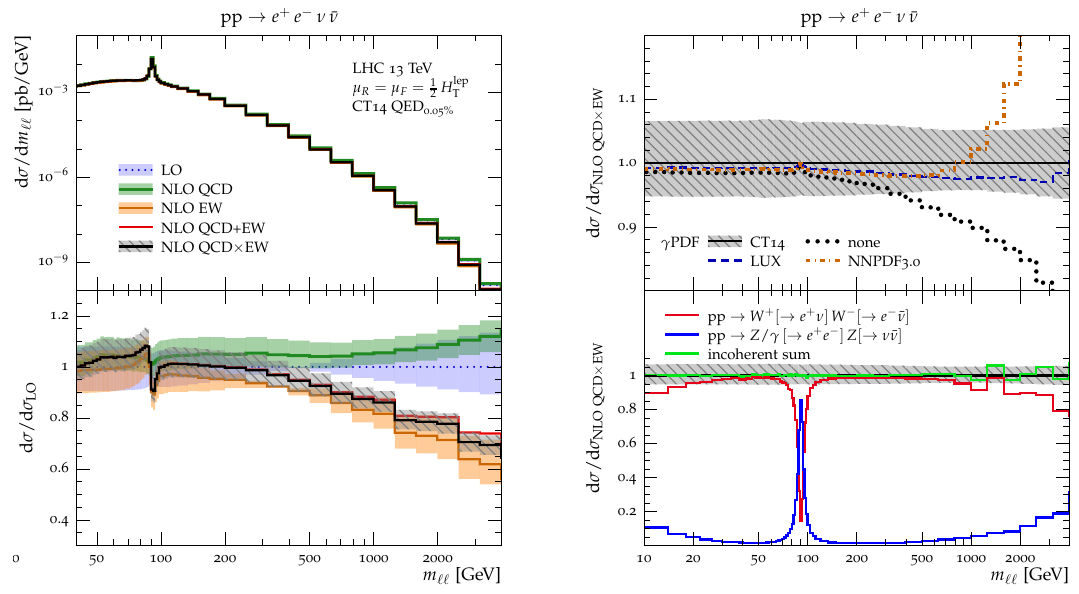
+ e (cid:0) (cid:23) (cid:22) (cid:23) at 13 TeV. Details as in (cid:12)gure 16. ‘‘ , for pp ! e